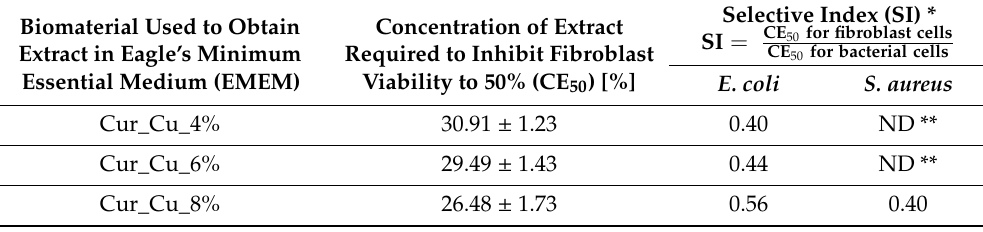
Table 3. The concentration of extract (CE 50 ) obtained from Cur_Cu_4%, Cur_Cu_6%, and Cur_Cu_8% biomaterials, which is required to inhibit fibroblast viability (BJ cells) to 50%. The CE 50 values were calculated via 4-parameter nonlinear regression analyses, GraphPad Prism 5, version 5.04). The values of selective index were calculated based on results obtained for bacteria and fibroblasts. The higher value of Selective Index (SI) is, the extract from biomaterial is safer for eukaryotic cells. Biomaterial Used to Obtain Extract in Eagle’s